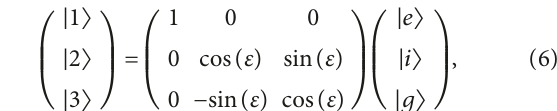
-configuration is the frequency of Λ Ω